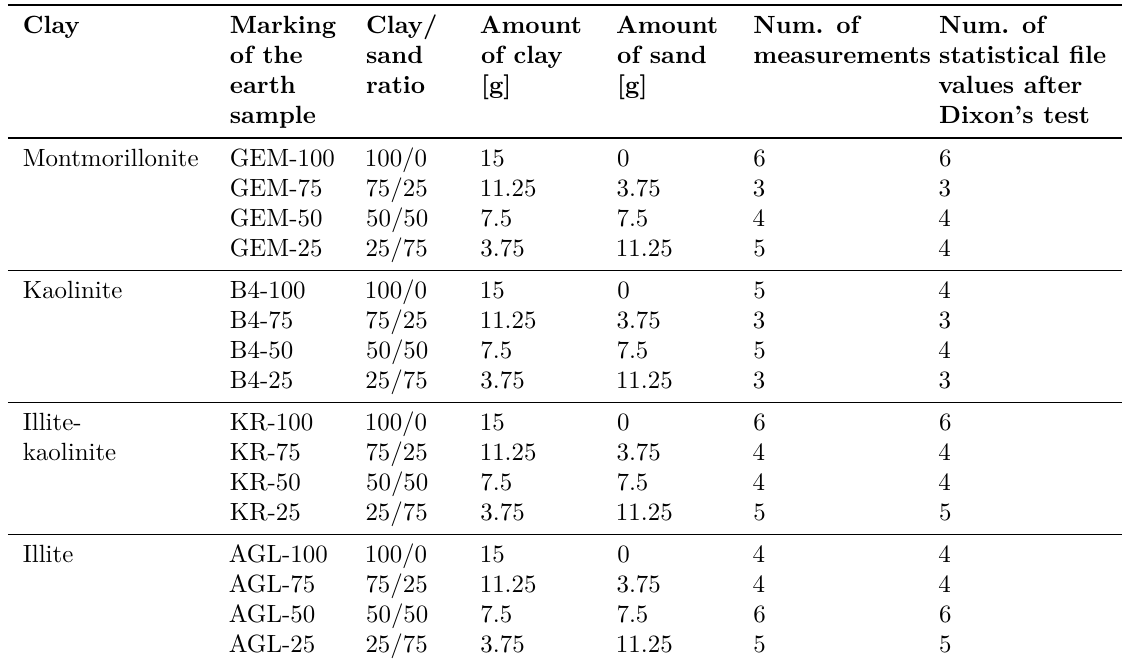
Table 2. Tested material overview.